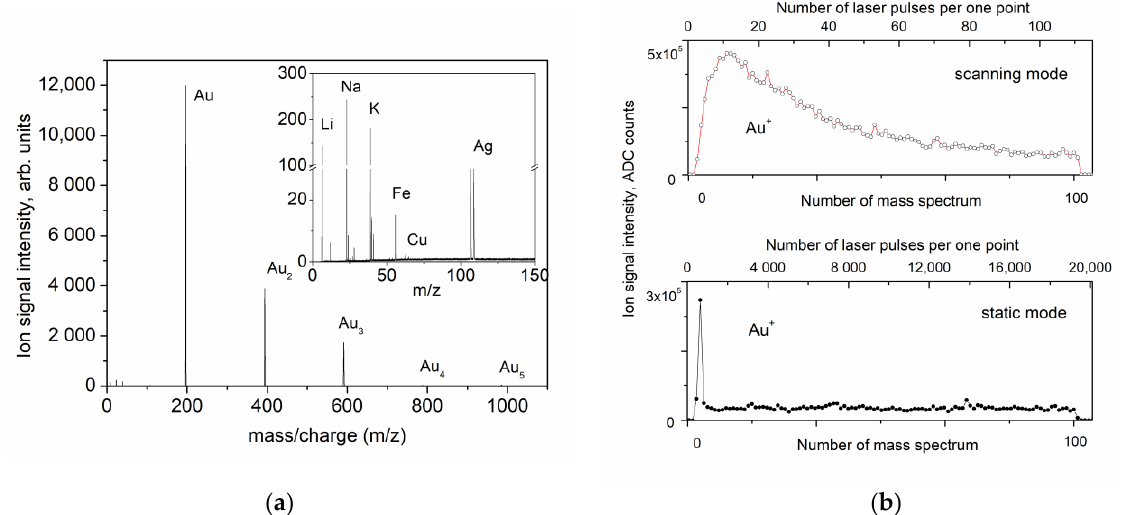
Figure 3. ( a ) Mass spectrum of the positive ions in static mode at a laser radiation energy of 2.7 μJ. Mass spectrum of the major impurities is presented in the inset. ( b ) Evolution of the Au + ion signal under successive exposure to laser pulses in scanning mode (top) and in static mode (bottom). Each point represents the sum of 174 successive mass spectrum records. The additional axis on the top of each diagram shows the number of laser shots per one point on the gold surface.